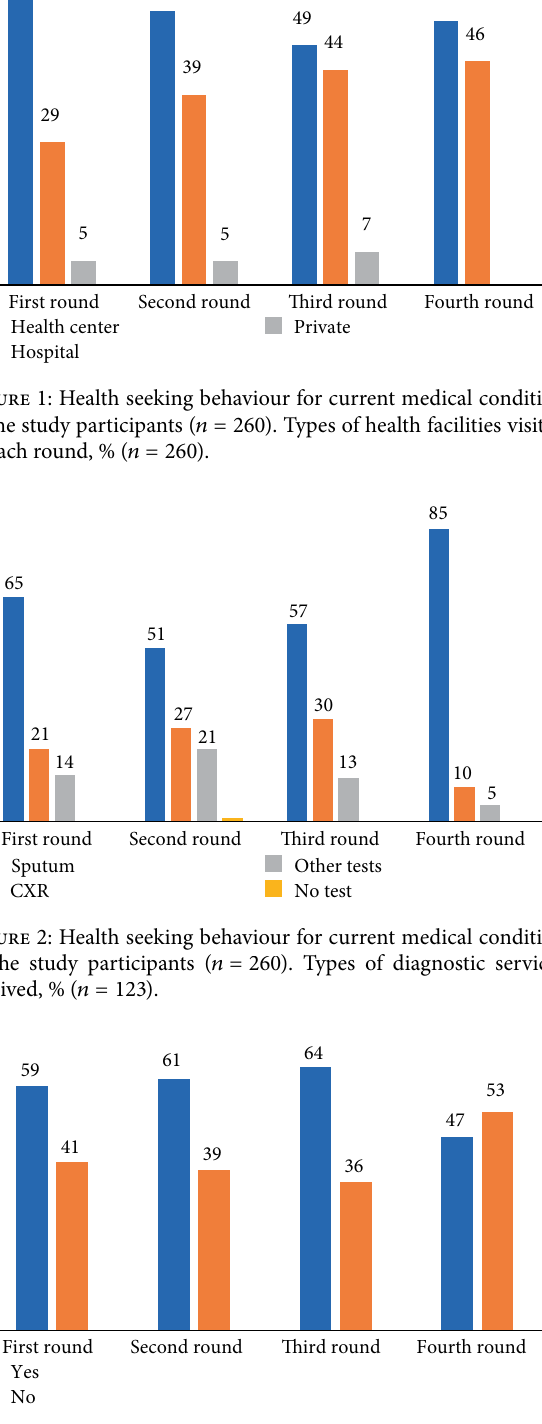
Figure 3: Health seeking behaviour for current medical condition of the study participants ( 𝑛 = 260 ). Treatment given, % ( 𝑛 = 64